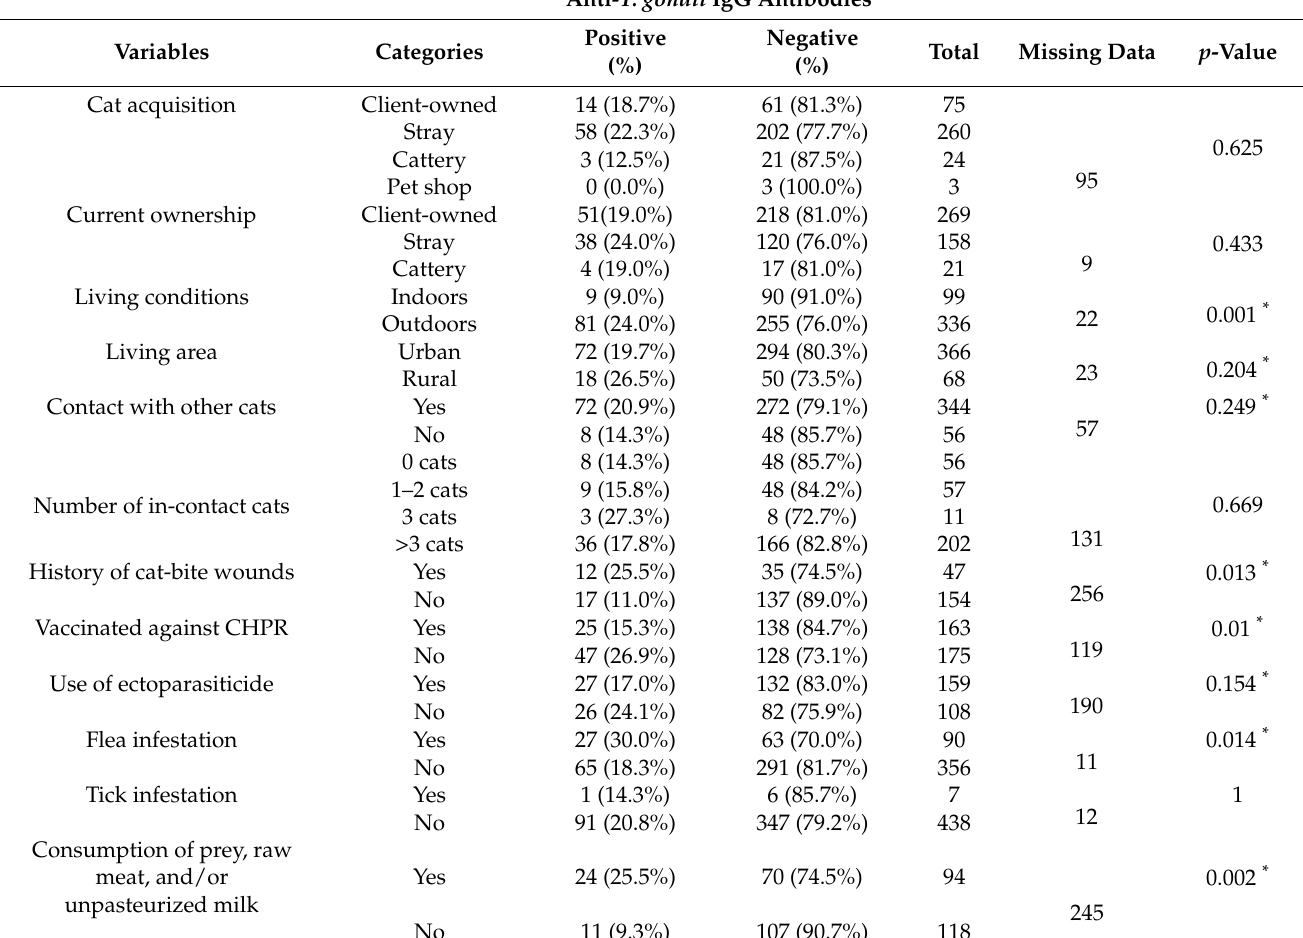
Anti- T. gondii IgG Antibodies